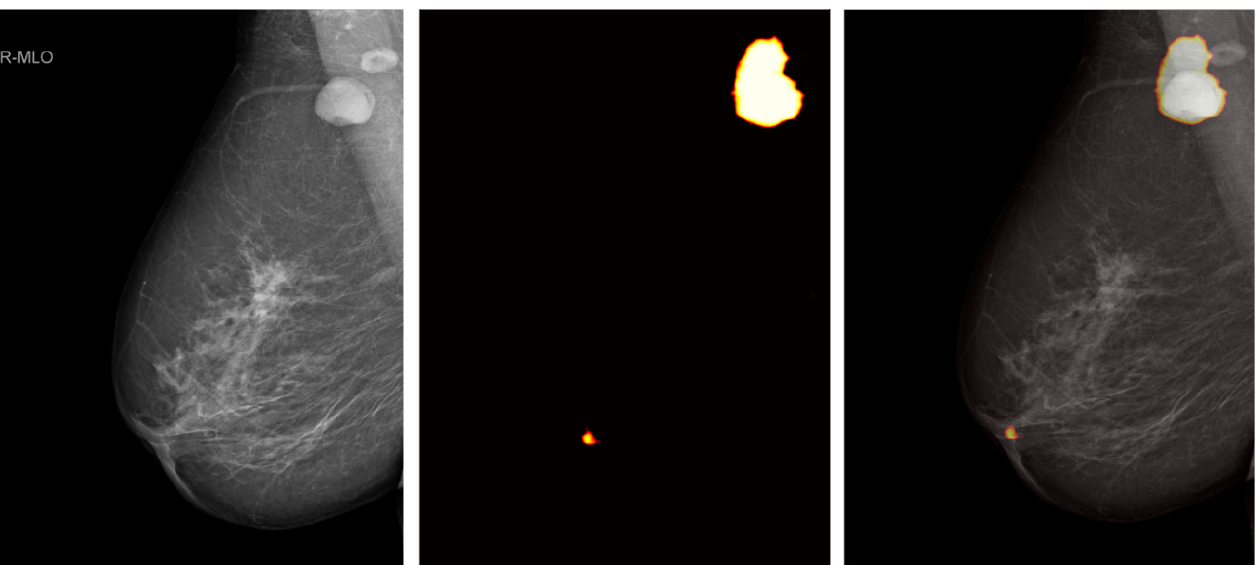
Figure 5. Heat colormap generated by the sliding window approach of a representative mammog- raphy in MLO projection. Left image is the original mammography, middle image the colormap, and the right image shows an overlay of both. Probability of class 3 (“suspicious lymph nodes”) is highlighted by a heat colormap.